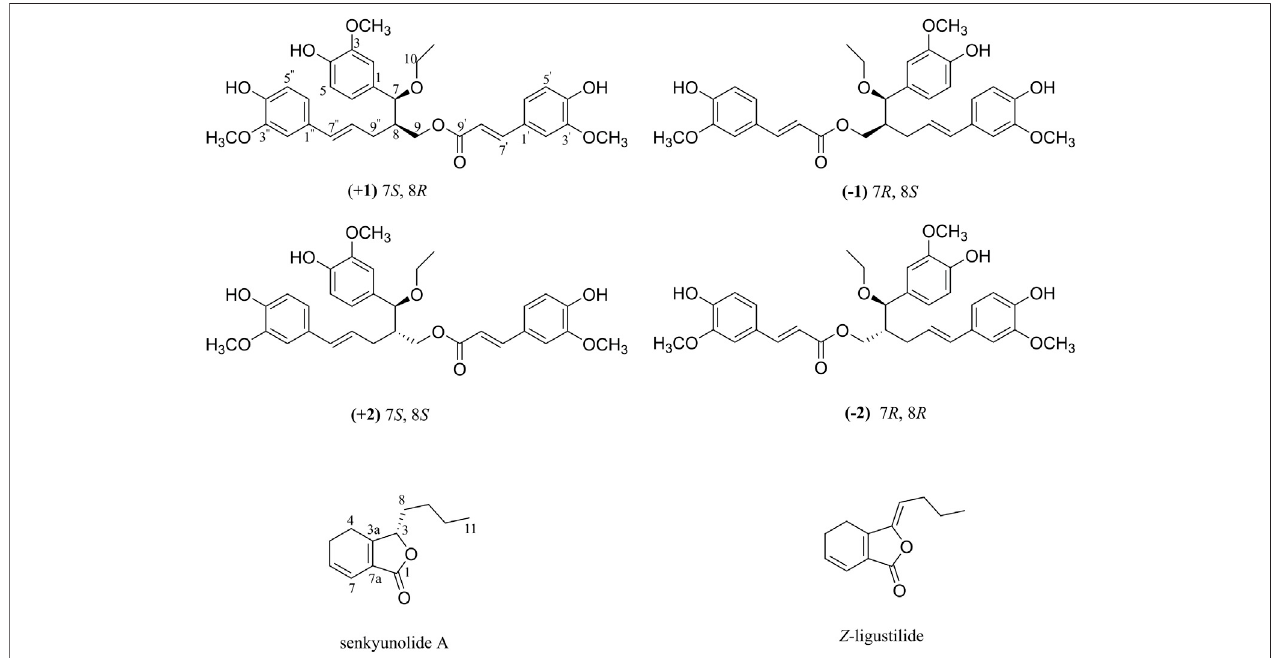
FIGURE 1 | Chemical structures of (±) 1 , (±) 2 , senkyunolide A and Z -ligustilide.